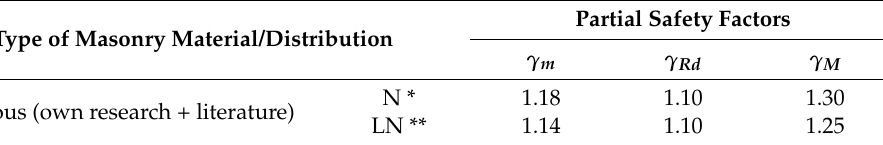
Table 10. Values of partial safety factors of the analyzed masonry structures determined for the RC2 reliability class and the 50-year reference